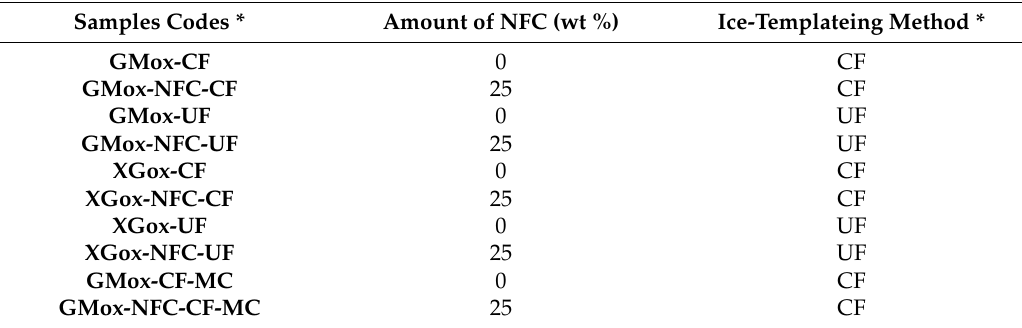
Table 1. Samples compositions and processing